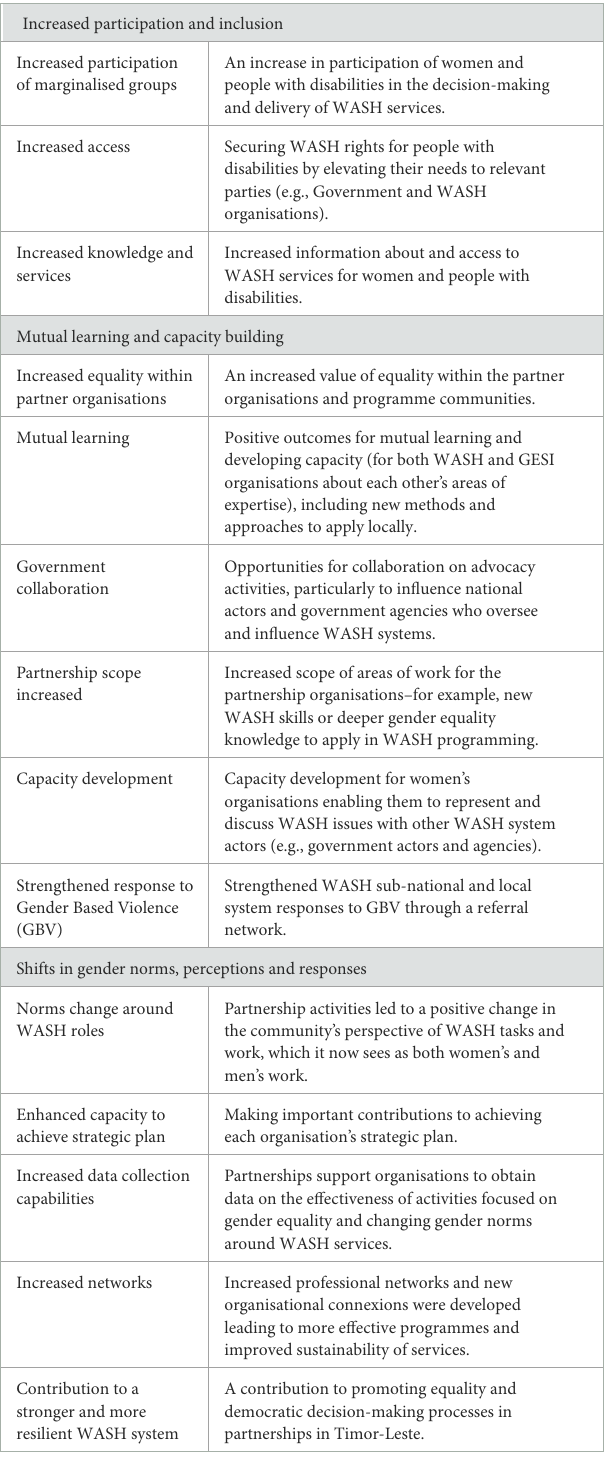
TABLE 1 Benefits reported by CSO interviewees ( n = 23) of partnerships between WASH and GESI